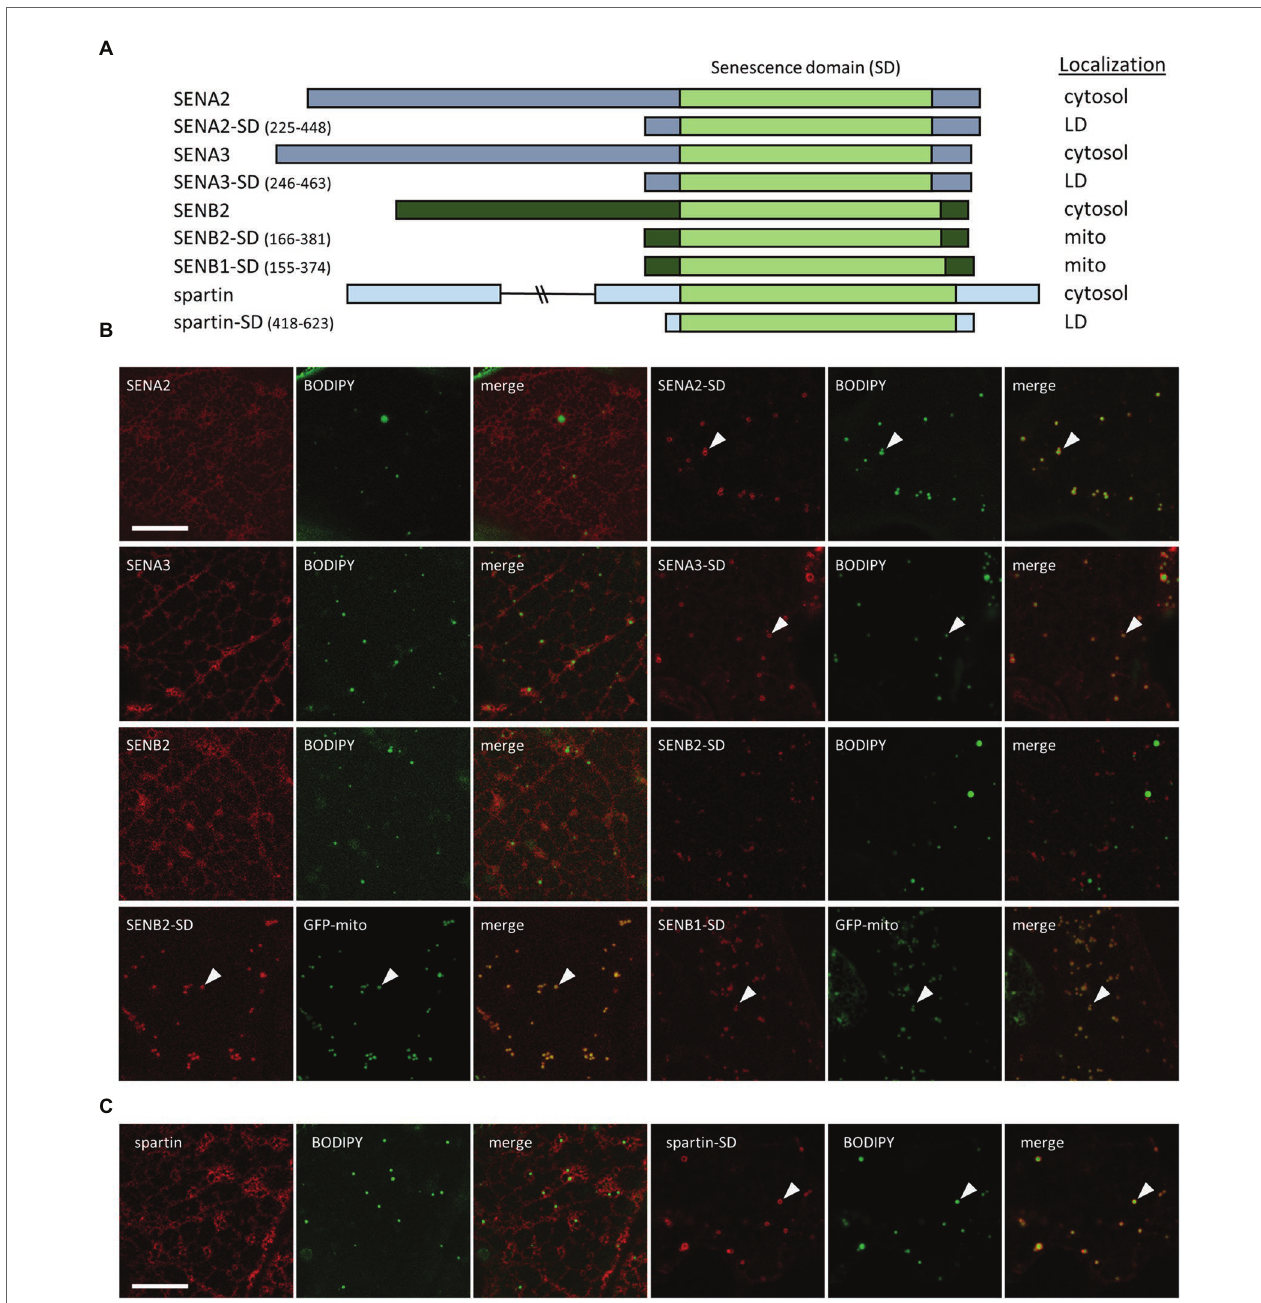
FIGURE 4 | Subcellular localization of various Arabidopsis SEN proteins and human spartin, and their corresponding SDs. N. benthamiana leaves were transiently transformed ( via Agrobacterium infiltration) with either full-length or the C-terminal portion, including their SD, of Arabidopsis SENA2, SENA3, SENB1, SENB2, or human spartin, and tagged at their C-termini with mCherry. Three days post-infiltration, leaves were stained with the neutral lipid dye BODIPY and imaged using CLSM. Alternatively, leaves were co-transformed with either SENB2-SD-mCherry or SENB1-SD-mCherry and the mitochondrial marker protein GFP-mito. (A) Schematic representations of the full-length and/or C-terminal SD-containing portion of each Arabidopsis SENA/B protein and human spartin, and their corresponding subcellular localization(s) [i.e., cytosol, lipid droplet (LD), mitochondria (mito)]. The SD in each protein is based on information obtained from the InterPro domain database. The numbers next to the name of each SD construct denote the amino acid residues that were fused to mCherry. The portion of each protein representing the SD is depicted in the illustrations as a light green box, while other regions of the SENA, SENB, and spartin proteins are depicted as gray, dark green, and blue boxes, respectively. Note that the C-terminal-appended mCherry moiety is not depicted in the illustrations or construct names. Representative CLSM images (z-sections) of mCherry-tagged full-length or truncated SEN-family proteins (B) or spartin (C) , along with the corresponding BODIPY-stained LDs or co-expressed GFP-mito in the same cell, and as indicated by panel labels. Also shown is the corresponding merged image. Arrowheads indicate examples of SENA/B or spartin fusion proteins that localized to BODIPY-stained LDs or GFP-mito-labeled mitochondria. Scale bars in (B,C) = 10 μ